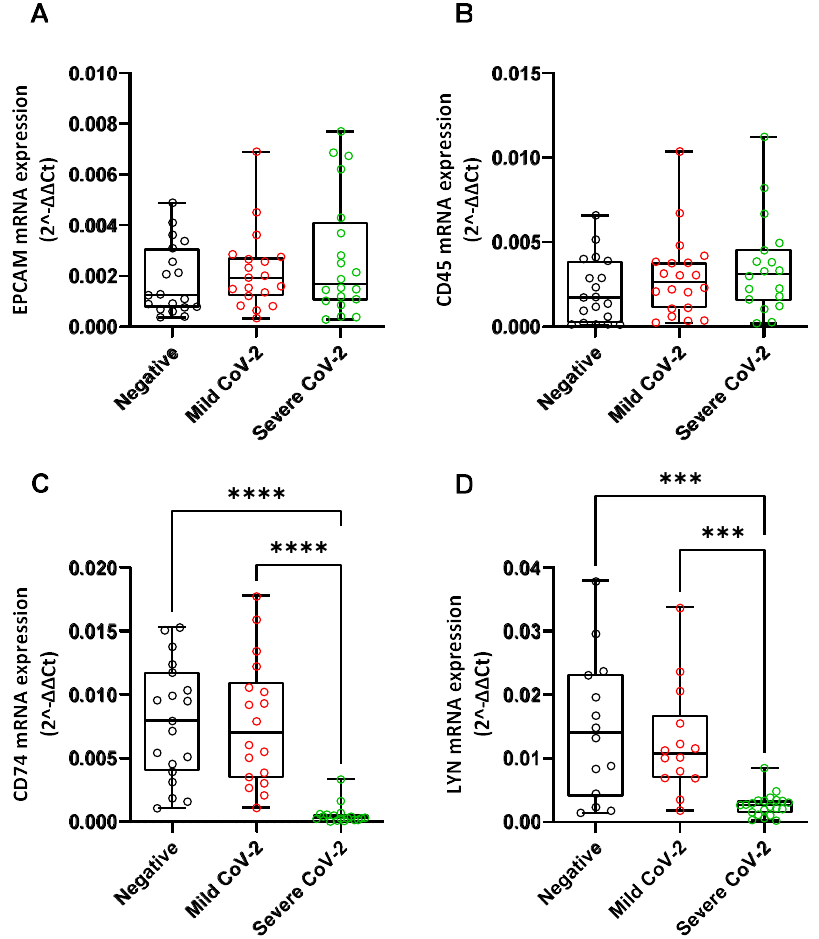
Figure 2. Comparison of the mRNA levels of EPCAM ( A ) , CD45 ( B ), CD74 ( C ) and LYN ( D ) in the nasopharyngeal swab samples of SARS-CoV-2 positive groups with mild (Mild CoV-2) or severe (Severe CoV-2) symptoms and SARS-CoV-2 negative cohort (Negative). Data are displayed as box plots and dots; the line in the middle corresponds to the median value; box edges, 25th to 75th centiles; whiskers, range of values. p -values were calculated with the non-parametric Kruskal–Wallis test. Dunn’s test was performed for multiple comparisons. *** p < 0.001, **** p <